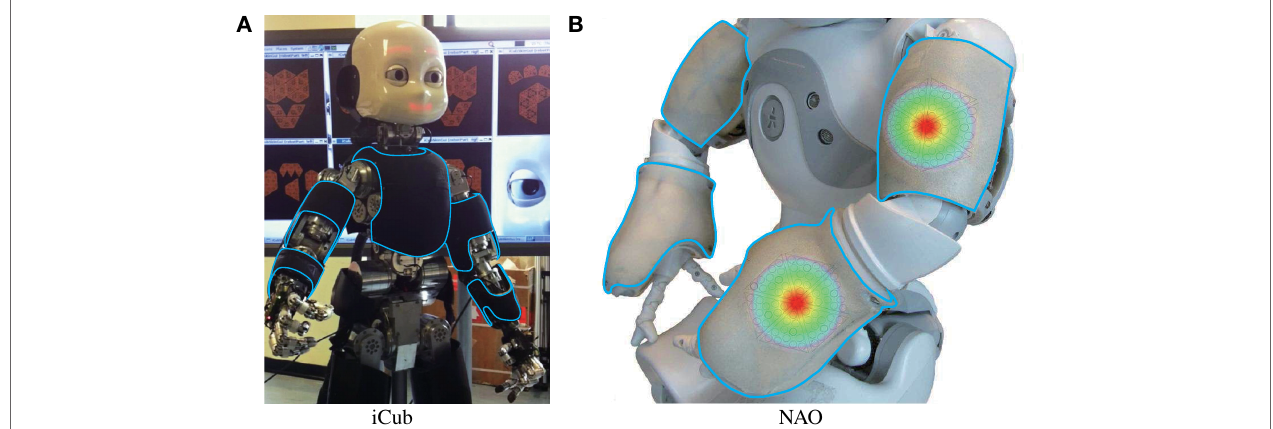
FIGURE 1 | (A,B) illustrate iCub and NAO robots, respectively. Their equipped robotic skin is highlighted. The TCI framework presented in this article was evaluated on both platforms and both on the real robots and in simulations.